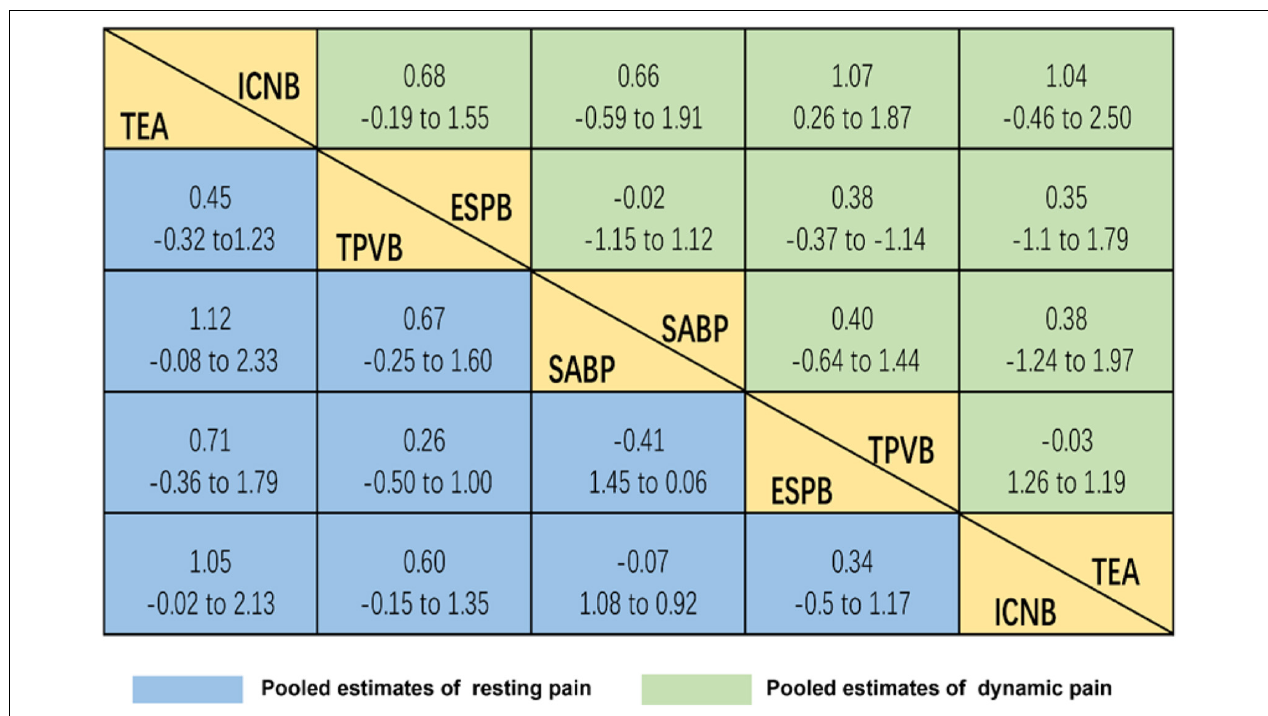
FIGURE 3 | Relative effect sizes of efficacy at post-treatment according to network meta-analysis. Treatments are orders in the rank of their chance of being the best treatment. For efficacy in post-treatment, standardized mean differences (SMDs) more than 0 favor the column-defining treatment. Significant superiority of locoregional analgesia for pain management after